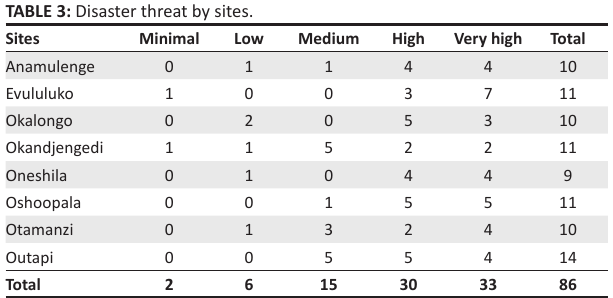
TABLE 3: Disaster threat by sites.